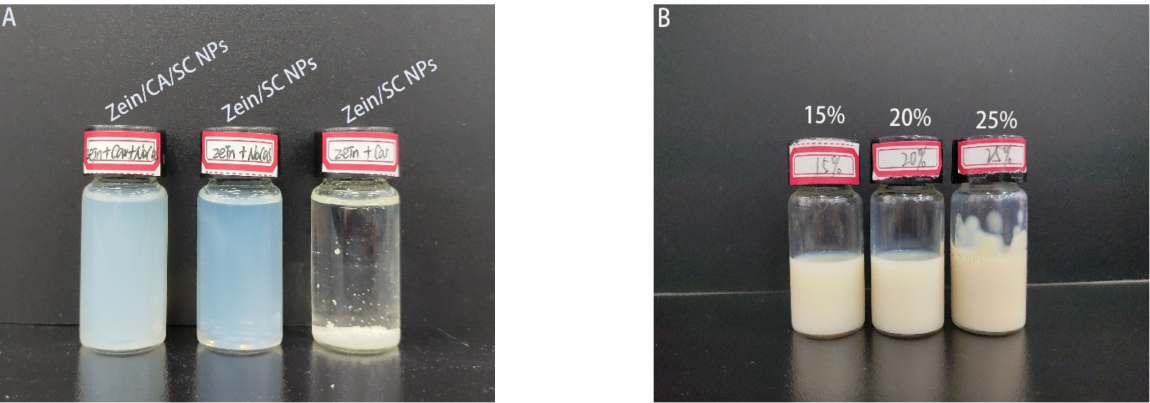
Figure 4. The redispersibility of nanoparticles. ( A ) Different samples at the same mass concentration of 0.2%. ( B ) The redispersibility of zein/CA/SC nanoparticles at mass concentrations of 15%, 20%, and